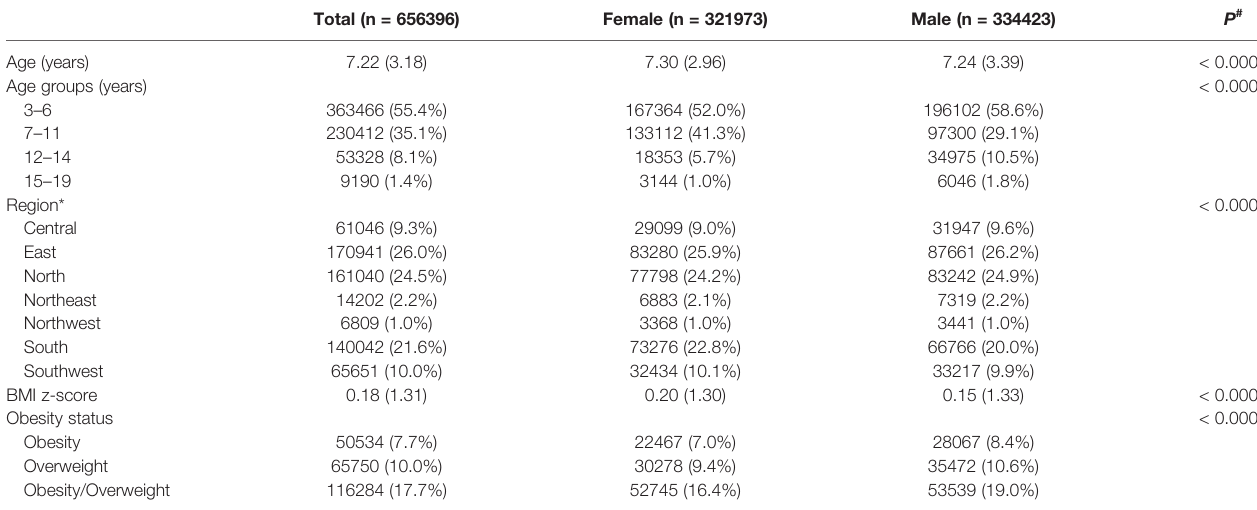
TABLE 1 | General characteristics of the study